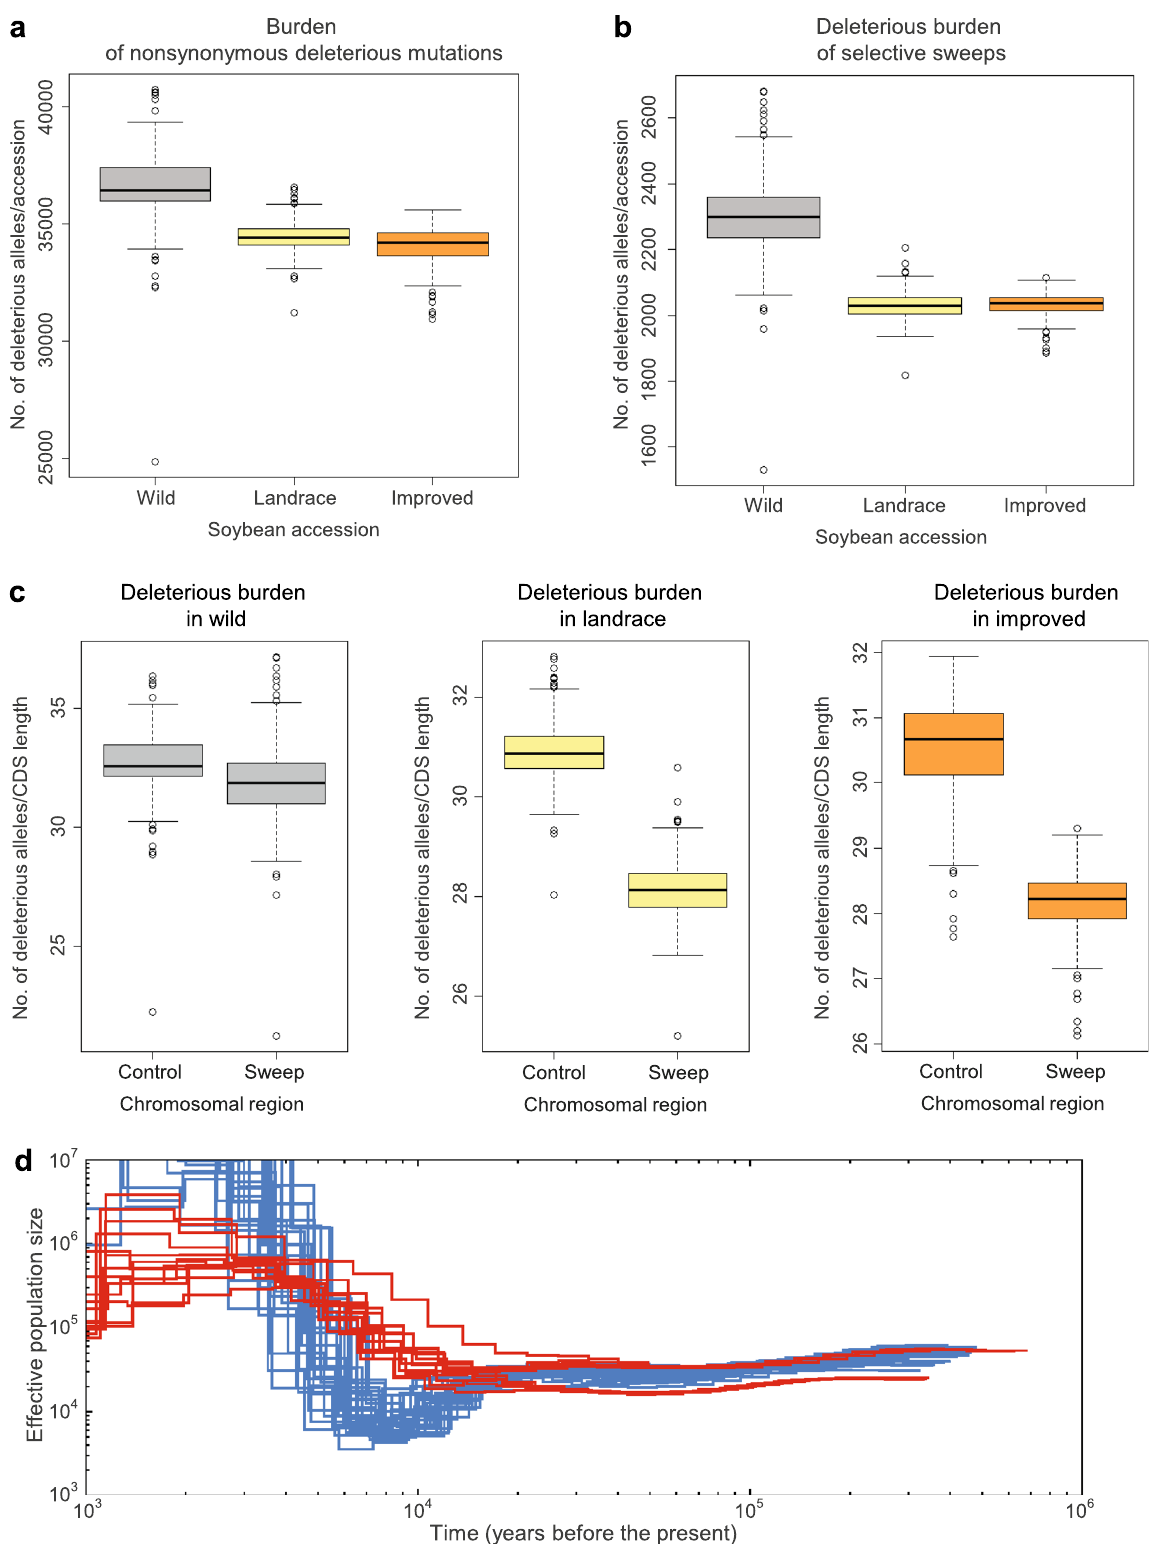
populations, within-population comparison of sweep regions with the rest of the genome in deleterious alleles showed that selective sweeps exhibited 9.0% (landraces) and 7.6% (improved lines) decreases ( P < 2.2e − 16, Fig. 4c) in deleterious alleles in domesticated soybean. However, in wild soybean, levels of